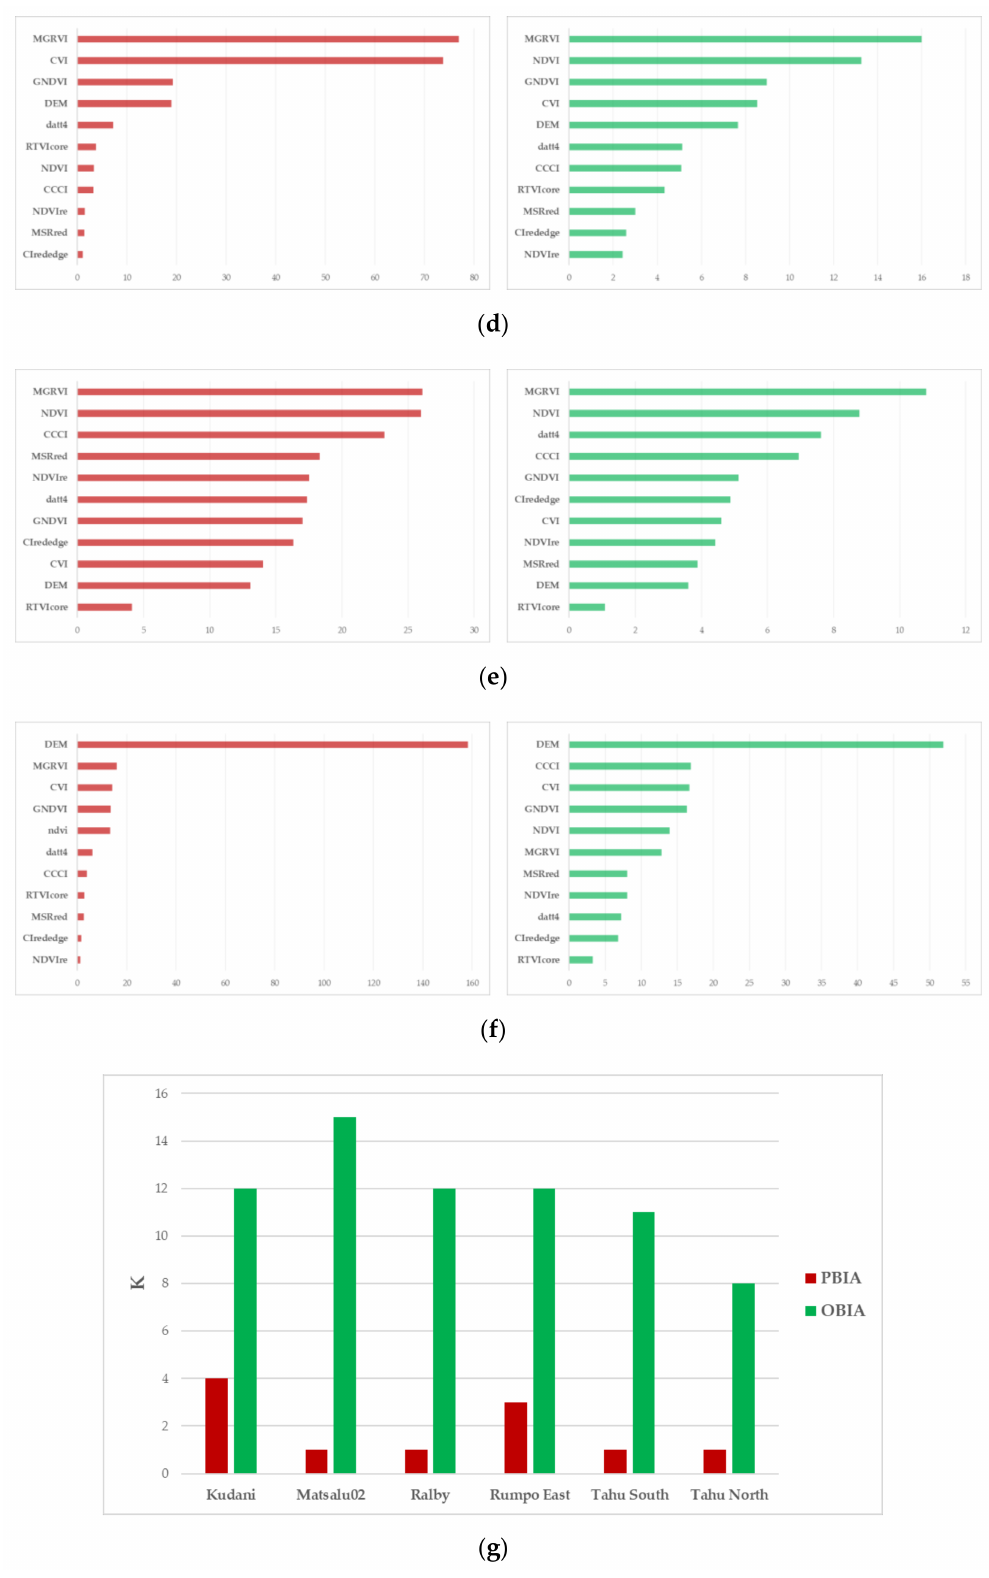
Figure 5. MDG scores in each study area. On the left, RF PBIA and on the right, RF OBIA. Study areas: ( a ) Kudani, ( b ) Ralby, ( c ) Rumpo East, ( d ) Tahu South, ( e ) Tahu North and ( f ) Matsalu02. The number of K-Nearest Neighbors used by the KNN classifier in PBIA and OBIA is shown in panel ( g